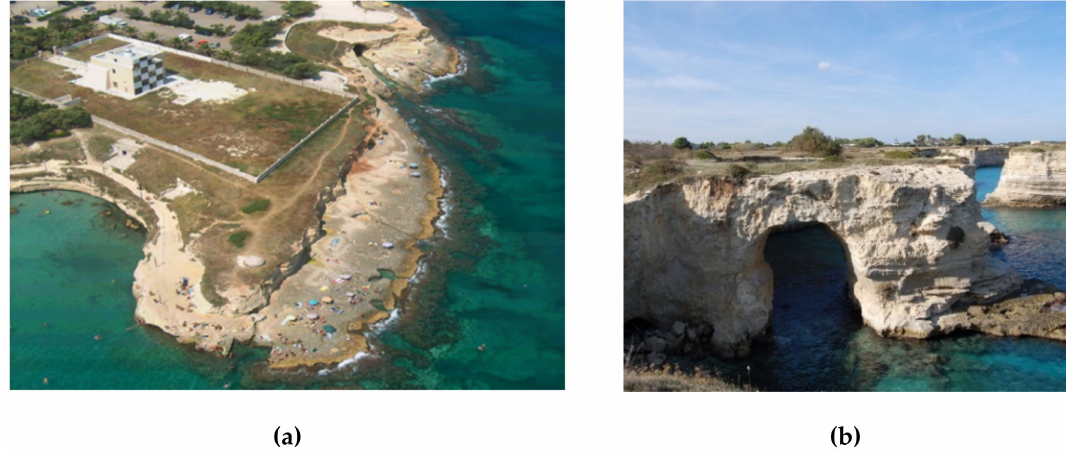
Figure 5. Cliffs with: ( a ) presence of a sub-horizontal platform and ( b ) cavity formations and leaf